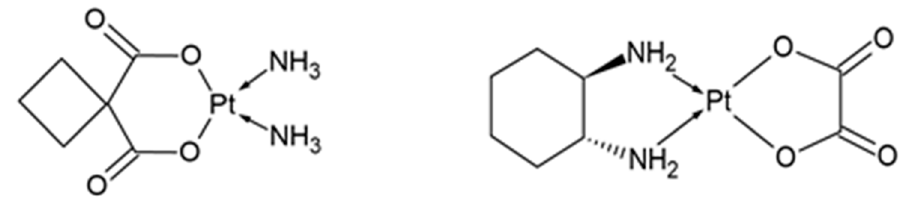
Figure 3. Chemical structure of carboplatin ( left ) and oxaliplatin ( right ).